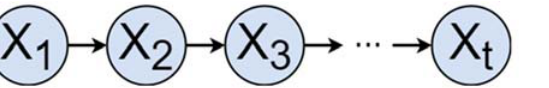
Figure 5. A temporal Bayesian network representation of a Markov process of order 1.